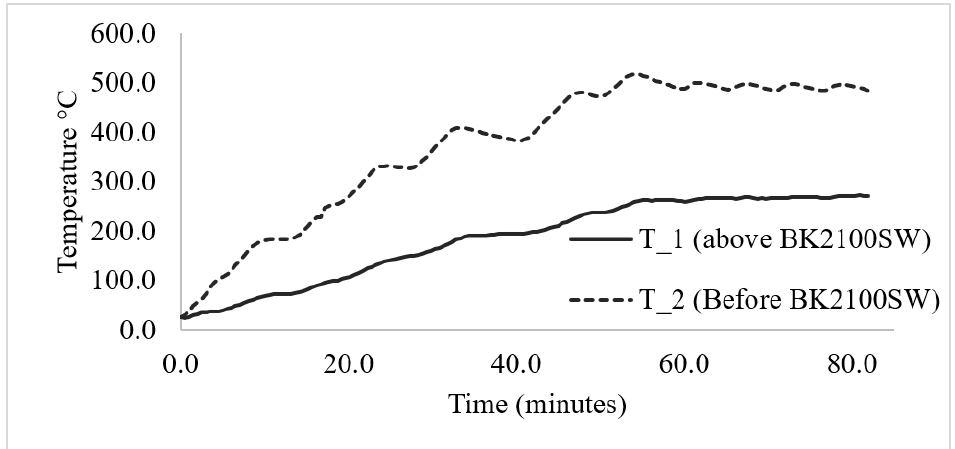
Figure 7. Cermex BK2100SW insulation mat temperature results.